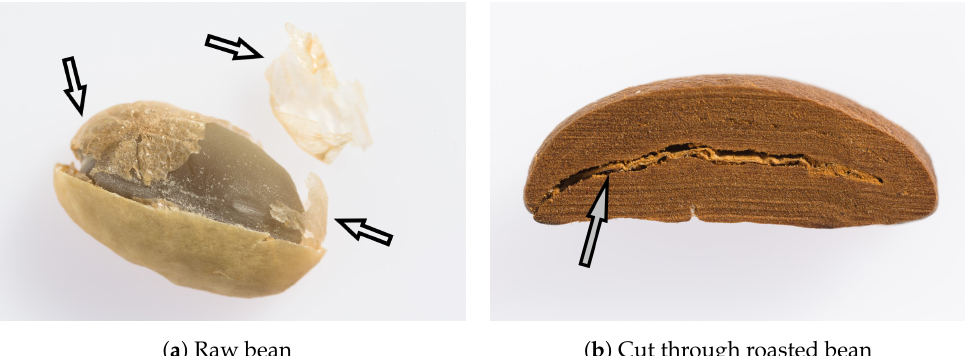
Figure 1. Macroscopic pictures of coffee beans (silver skin marked with arrows). ( a ) Raw coffee bean with silver skin exposed on upper half, silver skin partly detaching from bean. ( b ) Cut through roasted coffee bean showing the remaining silver skin between the two halves of the bean. Reproduced with permission from Fotodesign Luca Siermann, Wald-Michelbach,